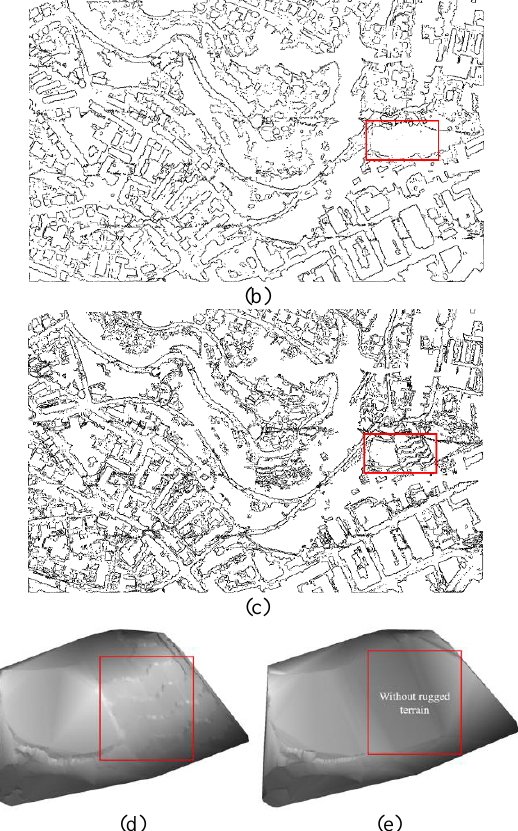
Figure 8. Results of the initial ground surface construction by TIN for the Cite1 in the second dataset, (a) is the selected initial ground surfaces (depicted by segments), (b) is the feature points including boundaries, the highest and lowest points, (c) is the 3D-edges detected by AGPN method, (d) is the TIN surfaces constructed by 3D-edges detected by AGPN, the small area corresponds to the red rectangles in (a)-(c), (e) is the TIN surfaces constructed by feature points, it corresponds to the area in (d). Figure 10. The results of the four small areas corresponding to figure